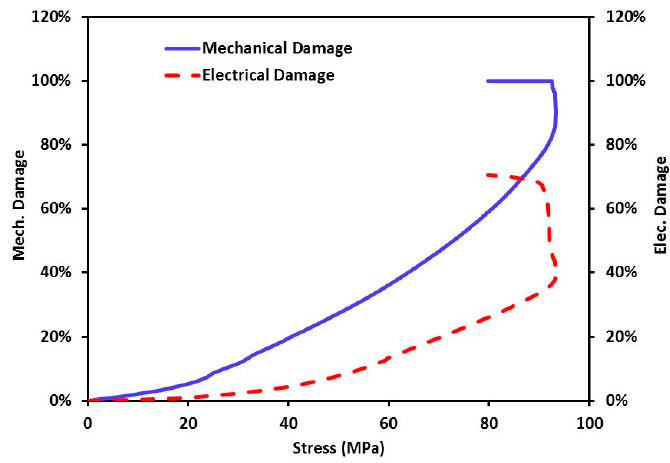
Figure 11. Stress-electrical damage ( D E ) and stress-mechanical damage ( D M ) for glass fiber composite incorporating CNFs under monotonically increasing static tension stress.